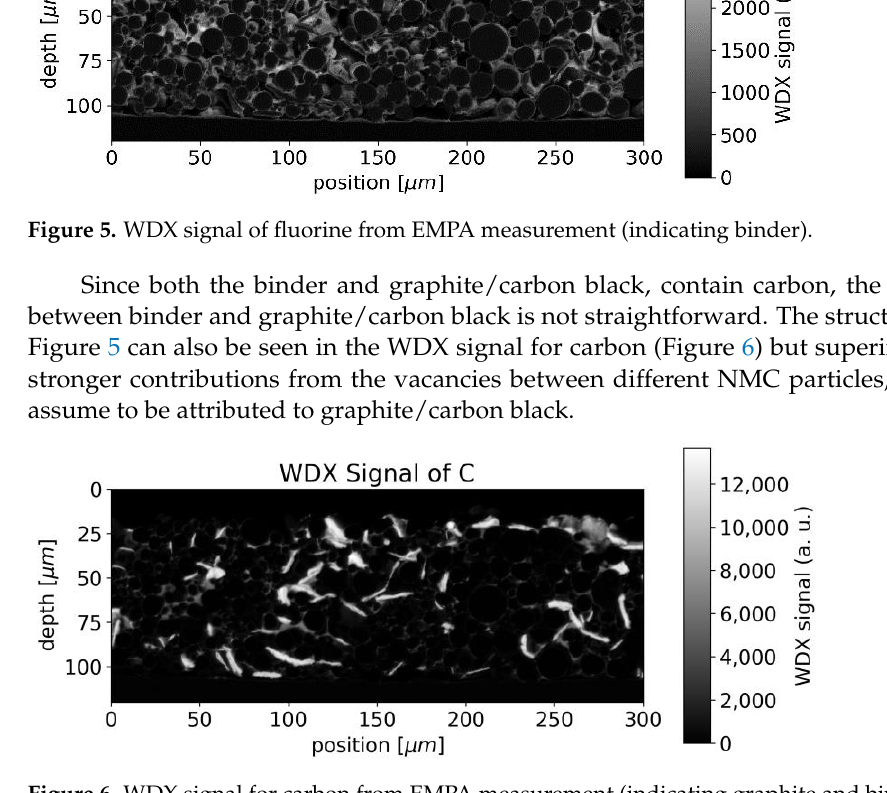
Figure 6. WDX signal for carbon from EMPA measurement (indicating graphite and binder).